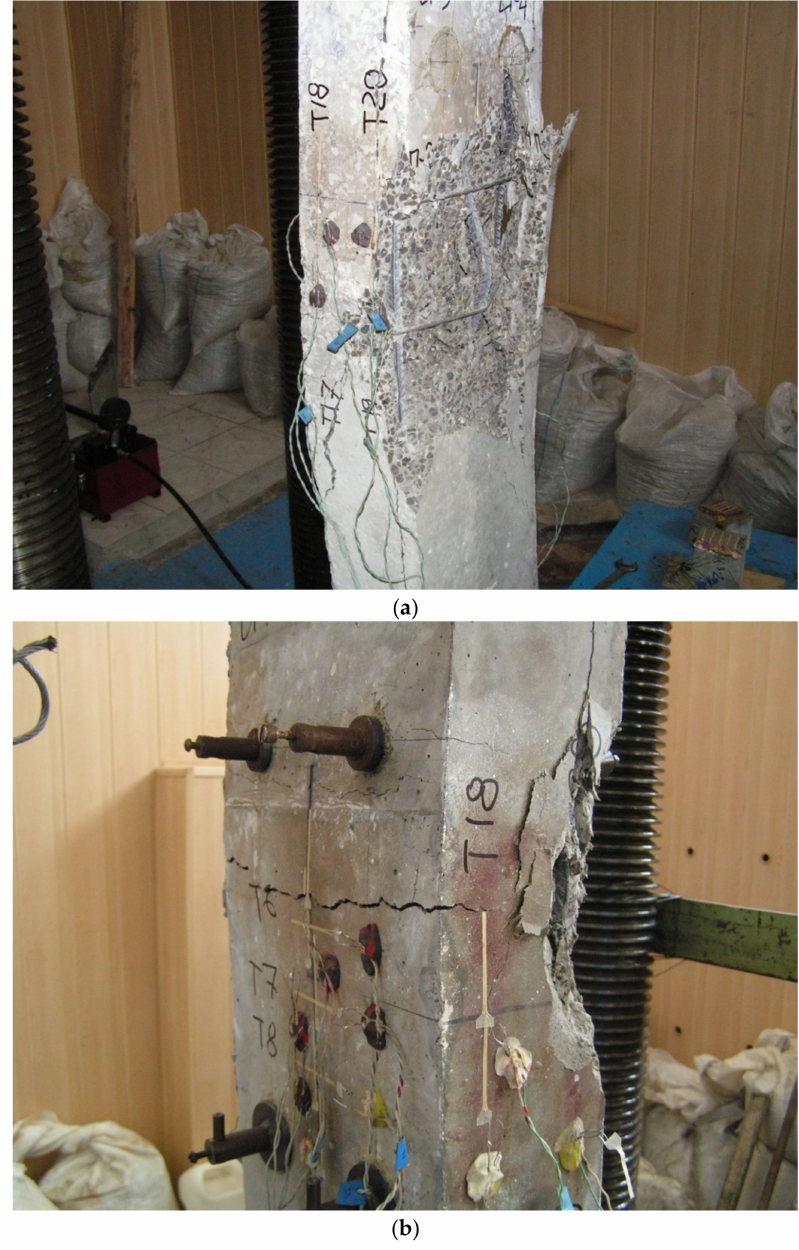
Figure 6. Photo of failure specimens: ( a ) KKF-0.15; ( b )